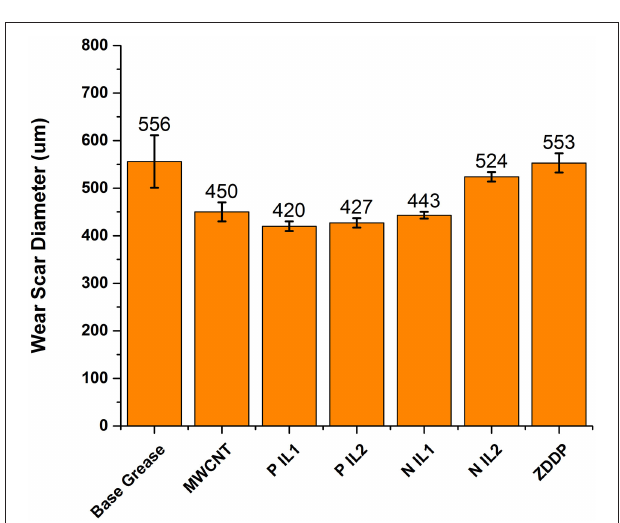
FIGURE 2 | Wear scar diameters from four ball wear tests for greases containing only MWCNT and only ILs additives compared with base grease and ZDDP grease